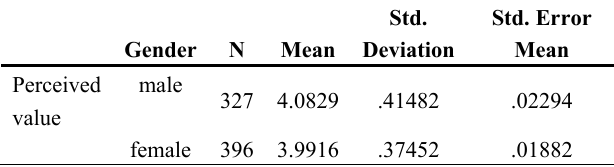
Table 13: The group statistics for the influence of the features of furniture product design on the fuzzy semantics of the perceived values of consumers with different genders